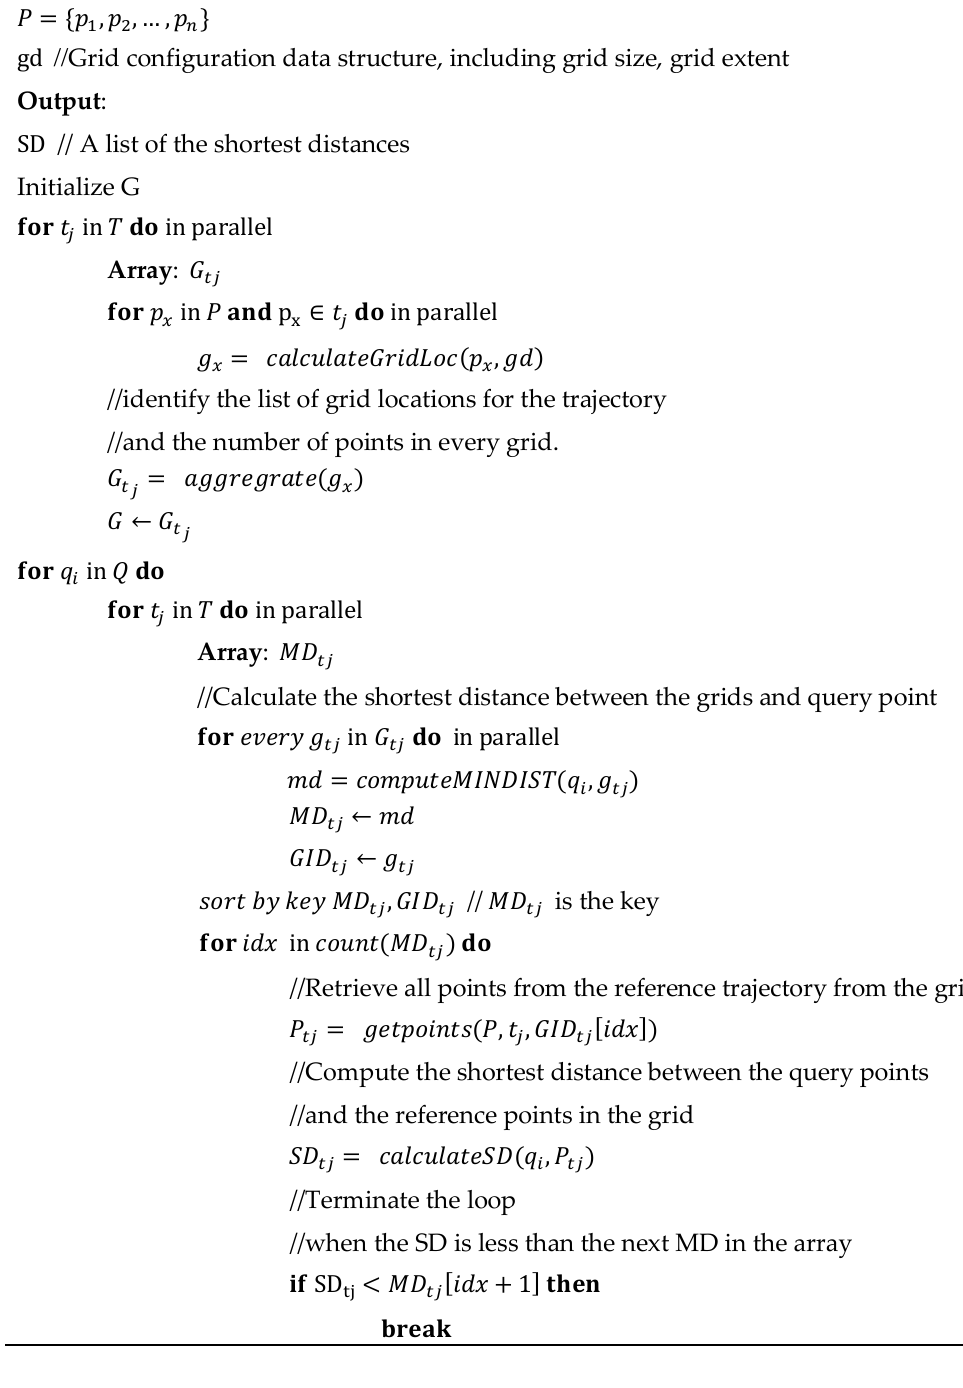
Figure 5. An example of the grid-based search method. ( a ) Original query and reference trajectories; ( b ) rasterized trajectory data; ( c ) distribution of query and reference points within grids and the matched point connection; ( d ) matched point connection when the order constraint is enforced. 3.3. Other Implementation Details We have implemented all algorithms with NVIDIA GPUs. CUDA Toolkit 9.0 C++ version is the Software Development Kit (SDK) used for development to achieve the best efficiency of data processing. Any recent NVIDIA GPUs should support the execution of the algorithms. However, the maximum possible data processed by the algorithms are determined by the hardware configuration (e.g., the main memory and the memory GPU devices). Users can configure the number of trajectories to be processed per round to avoid memory issues. We have also implemented a serial version for comparison analysis. 4. Case